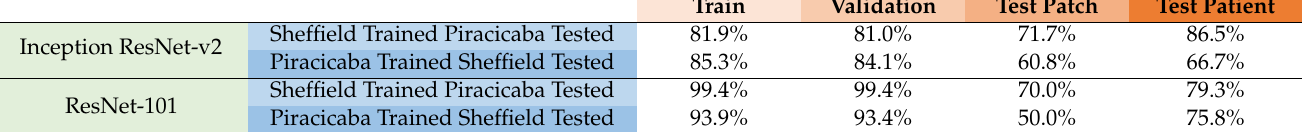
Table 6. Train and test with independent datasets